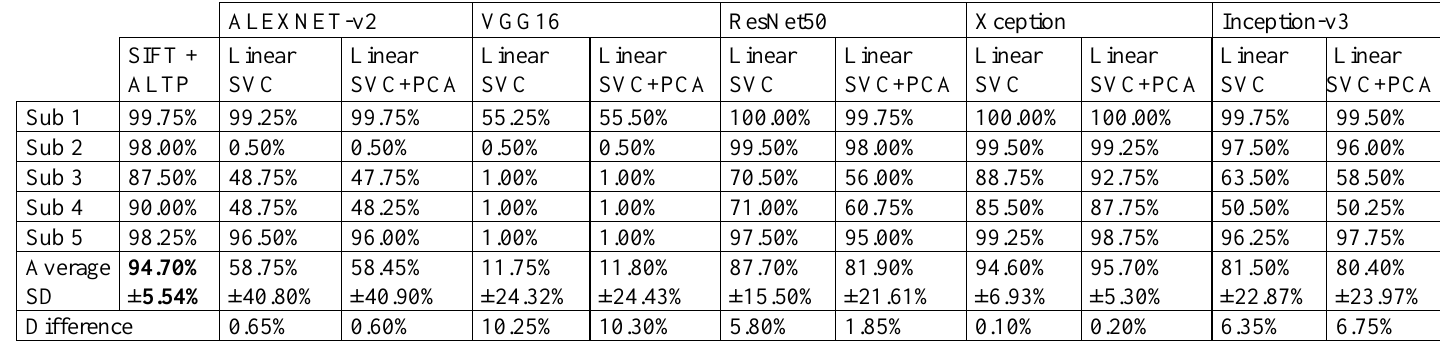
Table 7. Recognition accuracy ratio of SIFT +ALTP method and different deep learning models with data augmentation on the FERET database, and the difference of accuracies with various deep learning models trained without data